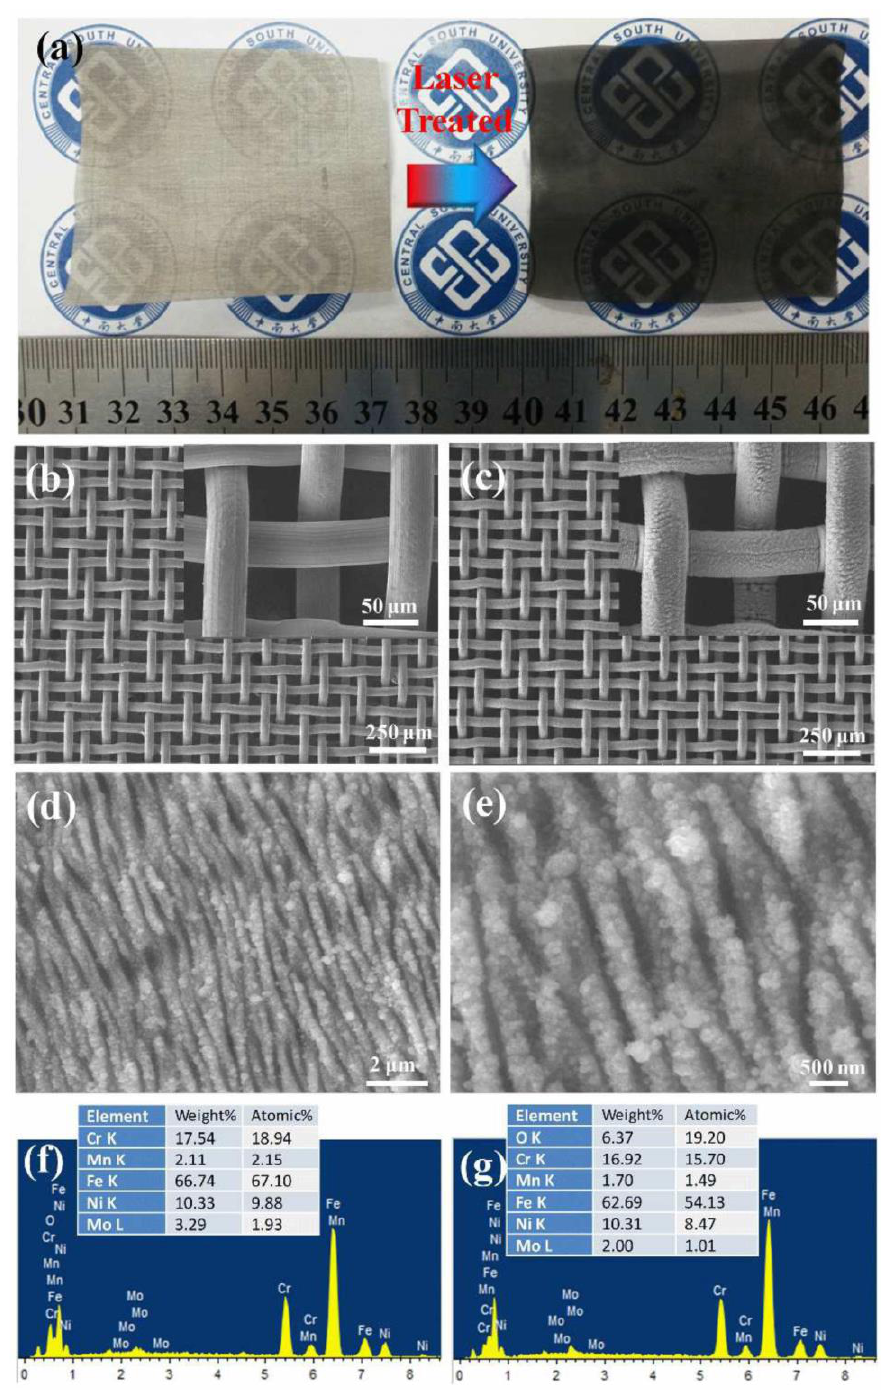
Figure 8. ( a ) Optical and ( b , c ) SEM images of stainless-steel mesh before and after FS laser treatment. ( d , e ) SEM images of LISR present on the FS laser-irradiated mesh, at different magnifications; ( f , g ) chemical composition analysis of the pristine and the laser-treated stainless-steel mesh [67]. Reproduced with permission from [67] Royal Society of Chemistry 2017.